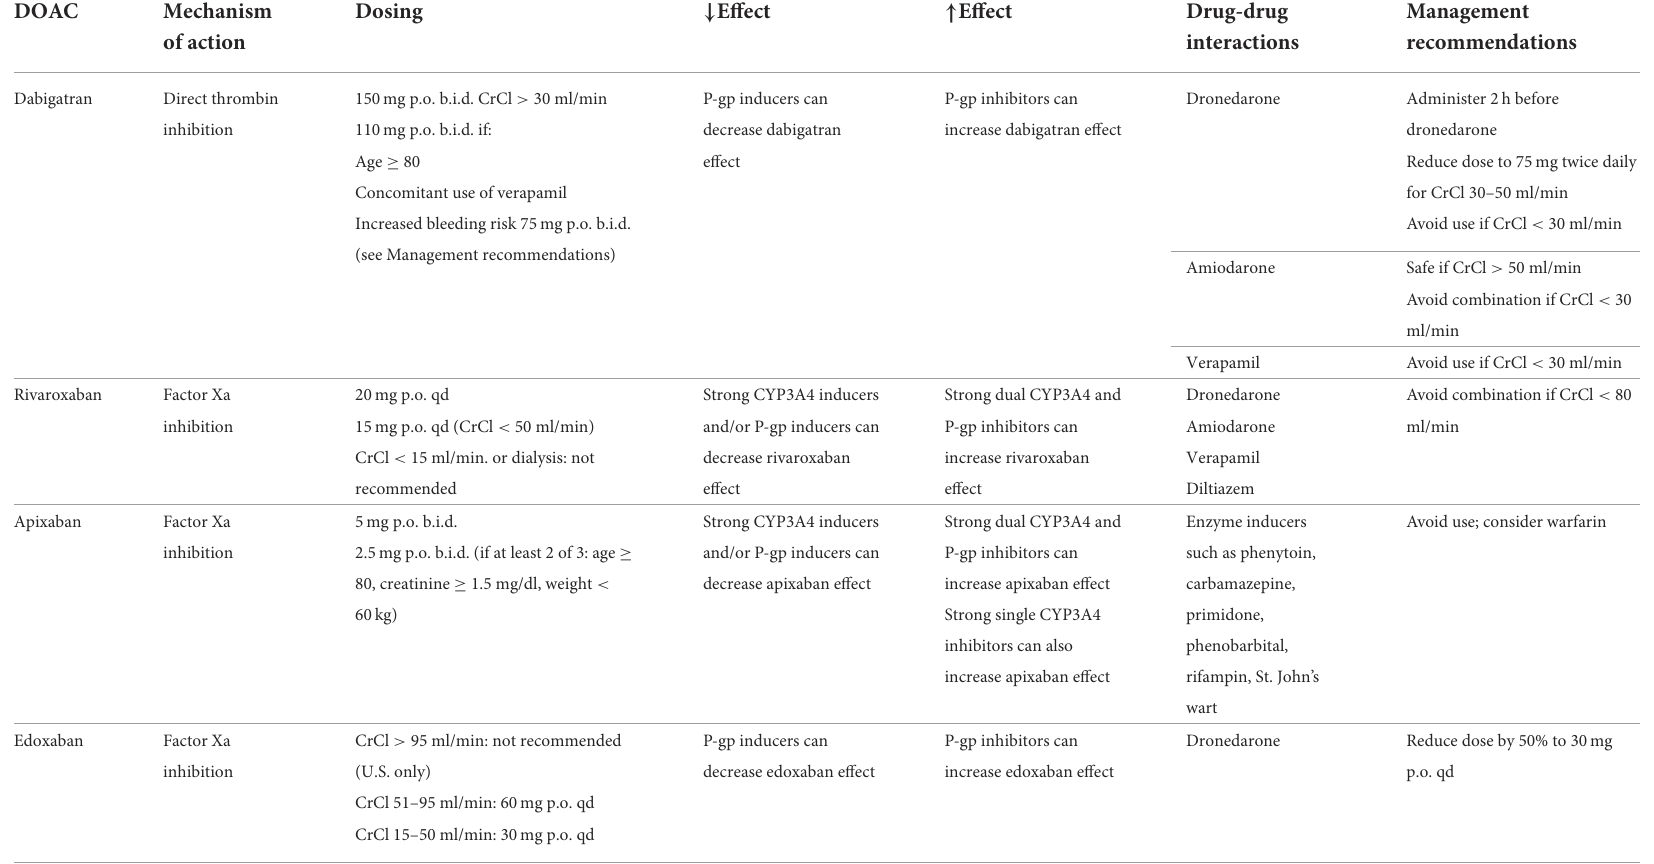
TABLE 3 DOACs: drug